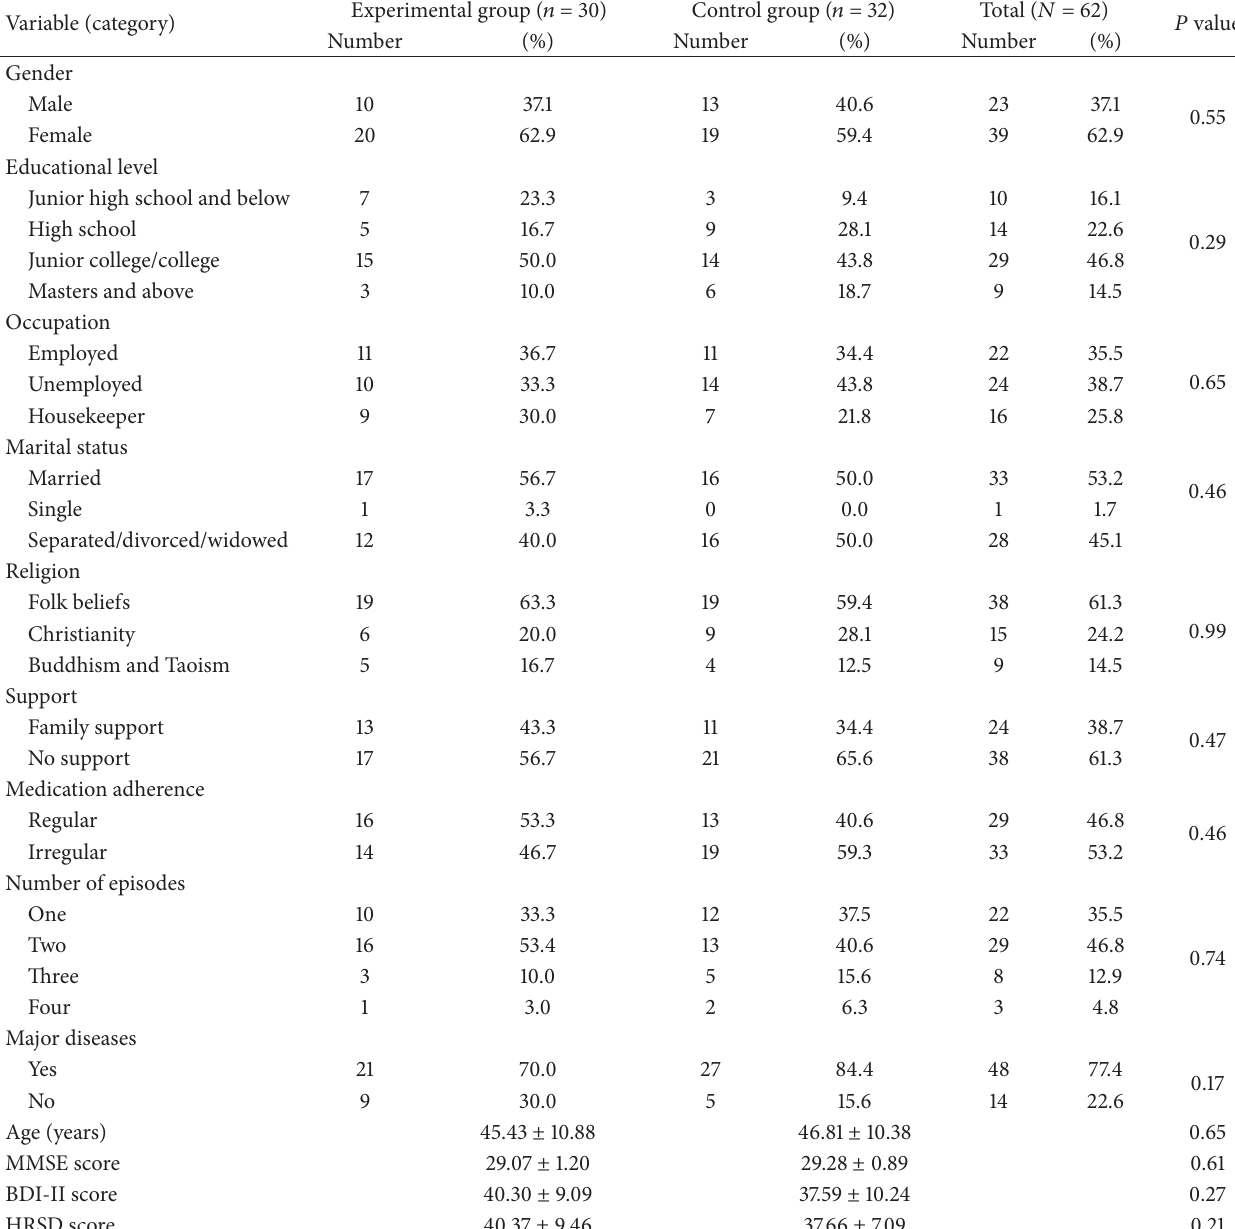
Table 1: Patient demographics ( 𝑁 =